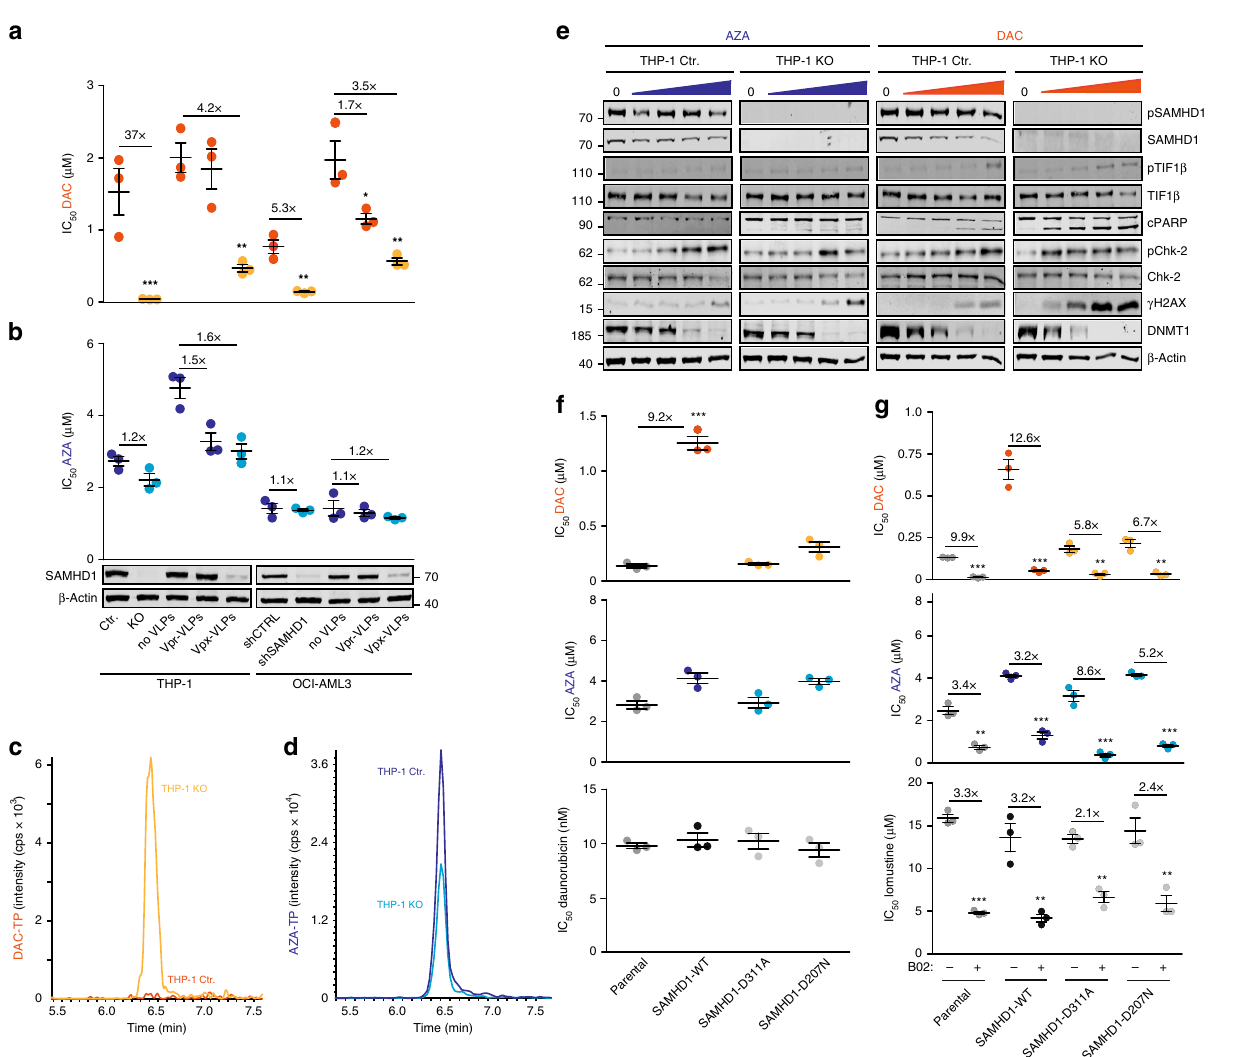
Fig. 3 SAMHD1 triphosphohydrolase activity controls DAC response. a , b IC 50 values for ( a ) DAC or ( b ) AZA in AML cell lines THP-1 and OCI-AML3 with experimentally modulated SAMHD1 levels. SAMHD1 was depleted by either CRISPR/Cas9-mediated SAMHD1 knockout in THP-1 cells (THP-1 KO), by shRNA-mediated silencing of SAMHD1 in OCI-AML3 cells, or by transduction with VLPs carrying SAMHD1-degrading Vpx protein (Vpx-VLPs). Unedited THP-1 cells (THP-1 Ctr.), cells transduced with control-shRNAs (shCTRL), or cells treated with Vpr-carrying VLPs (Vpr-VLPs) served as controls. Each point represents an average of three technical replicates, and in each case, as shown, three independent experiments were performed. Horizontal lines and error bars represent means ± s.d. The numbers above the data points indicate the factor of decrease of IC 50 values in SAMHD1-depleted cells relative to control cells. Representative SAMHD1 immunoblots for the different experimental conditions are shown. β -Actin served as a loading control. c , d Representative LC – MS/MS analyses of ( c ) DAC-TP levels or ( d ) AZA-TP levels in THP-1 Ctr. or THP-1 KO cells. e Representative immunoblots of proteins involved in DNA damage response and DNA methylation in THP-1 Ctr. or THP-1 KO cells following treatment with increasing concentrations (0, 0.08, 0.4, 2, and 10 µ M) of either AZA (left panels) or DAC (right panels) for 72 h. f , g IC 50 values of ( f ) DAC, AZA and daunorubicin or ( g ) DAC, AZA and lomustine without or with the RAD51 inhibitor B02 in parental HEL cells and HEL cells overexpressing either SAMHD1-WT or the dNTPase-defective SAMHD1 mutants SAMHD1-D311A or SAMHD1-D207N. Each closed circle represents a technical replicate ( n = 3) of one representative experiment out of three. Horizontal lines and error bars represent mean ± s.d. Numbers indicate the factor of decrease of IC 50 values in SAMHD1-depleted relative to control cells. Statistical analyses were performed using unpaired two-tailed Students ’ t -test. ** p < 0.01; *** p < of clinically achievable steady-state plasma levels of these HMAs SAMHD1-expressing cells (Fig. 3e, left panels and Supplementary (DAC: 0.3 – 1.6 µM; AZA: 3 – 11 µM) 36 – 38 . Short-term (3 days) Fig. 21b). Together, this indicates that SAMHD1 also affects exposure of parental HL-60 cells with DAC or AZA did not result demethylation caused by AZA-derived DAC-TP. in increased SAMHD1 expression, although DNMT1 levels and global DNA methylation were already found to be suppressed AML cell adaptation to HMAs results in SAMHD1 upregula- (Supplementary Fig. 22). In contrast, all three long-term selected, tion . Next, we explored the potential role of SAMHD1 in AZA-resistant (rAZA; I – III) and rDAC HL-60 sublines displayed acquired resistance formation to HMAs. SAMHD1-low- increased SAMHD1 expression at the protein (Fig. 4a) and expressing HL-60 cells were gradually adapted over a period of mRNA levels (Supplementary Fig. 23). rDAC sublines were at least 6 months to proliferation in the presence of either DAC highly resistant to DAC (Fig. 4b), but not or only marginally (1 µM) or AZA (10 µM), concentrations that are within the range